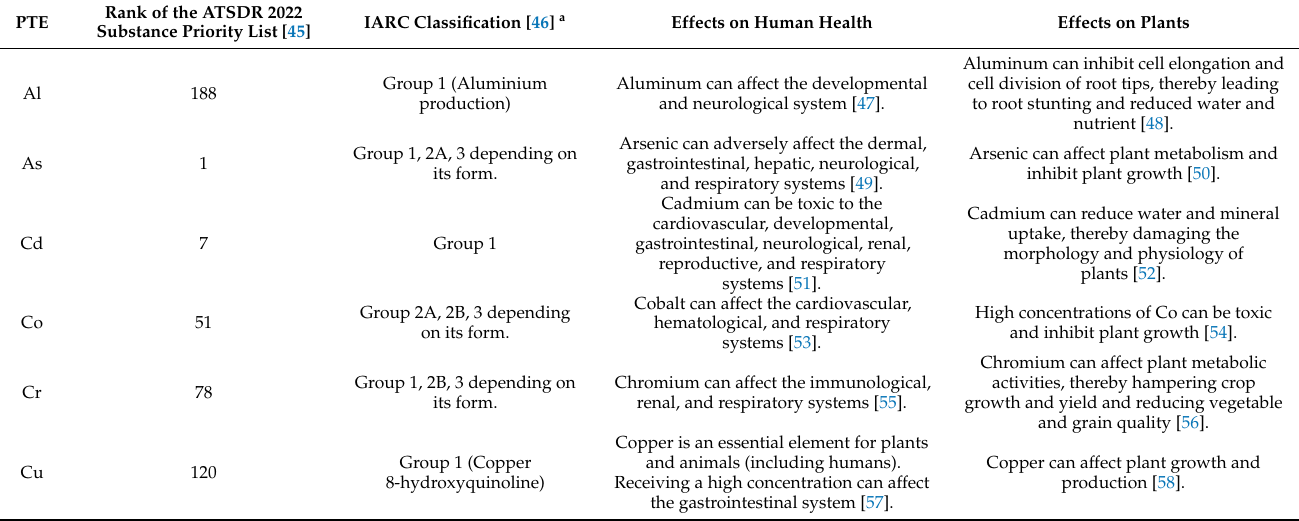
Table 5. Possible effects of the potentially toxic elements (PTEs) on human health and